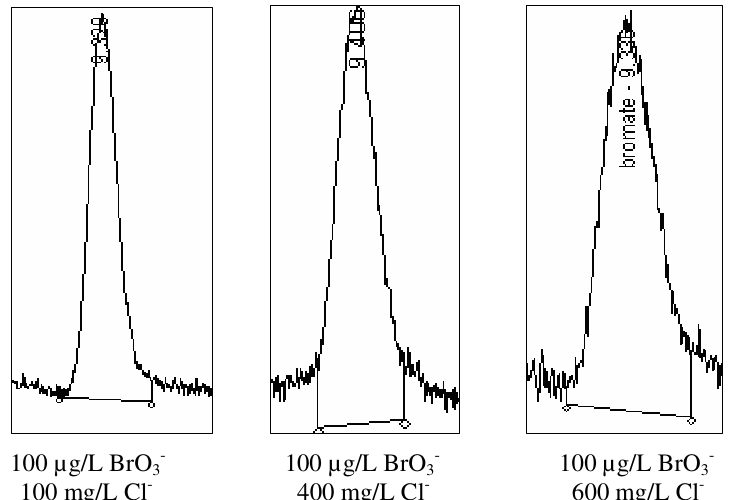
Figure 3. Effects of chloride ion on the bromate ion peak chromatographic conditions